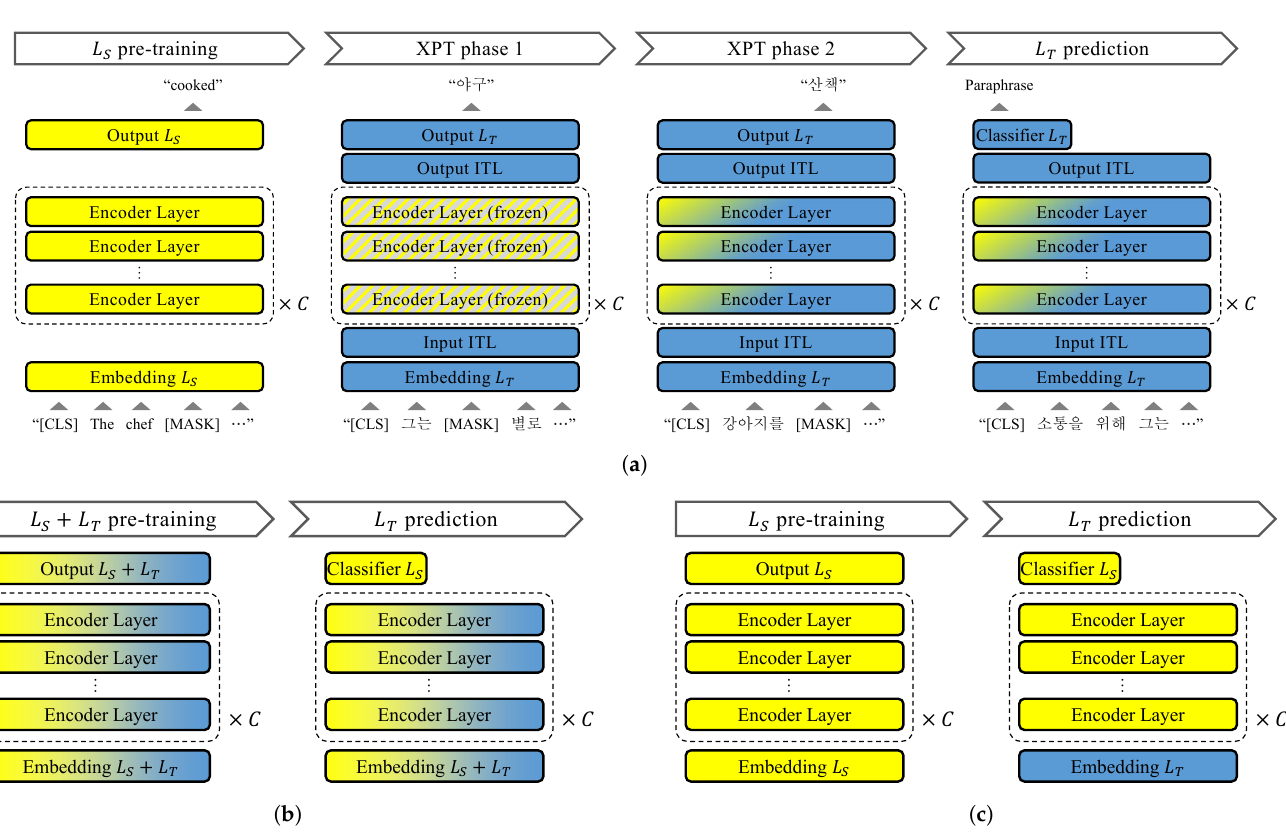
Figure 2. Illustration of the proposed approach and previous approaches. ( a ) Cross-lingual post-training (ours). ( b ) Multilingual language model pretraining. ( c ) Monolingual transfer